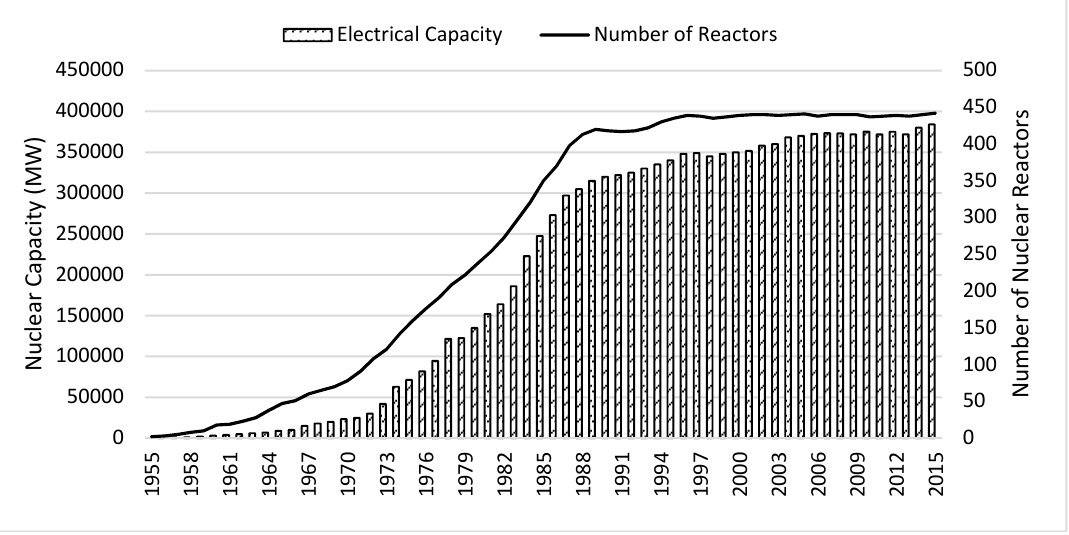
Figure 10 . Global variation of functional nuclear plants with their total capacity (MW) between 1955– Figure 10. Global variation of functional nuclear plants with their total capacity (MW)